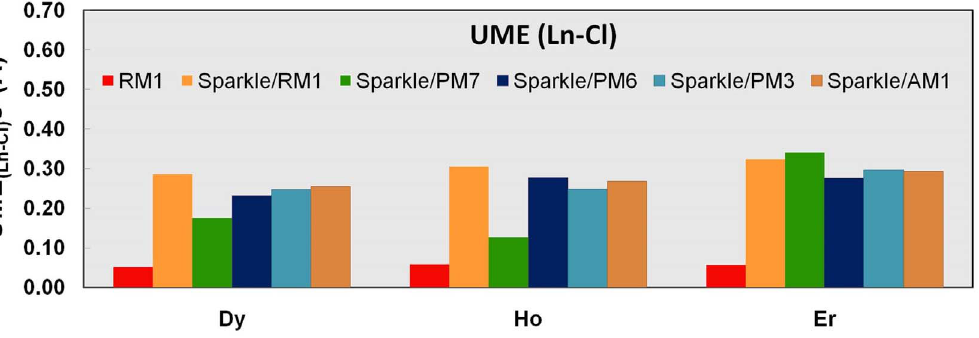
Figure 6. UME (Ln-Cl) s obtained using the RM1 model for the lanthanides and all five versions of the Sparkle Model: Sparkle/RM1, Sparkle/PM7, Sparkle/PM6, Sparkle/PM3 and Sparkle/AM1 for all complexes of the universe set for each of the lanthanide trications: Dy(III), Ho(III) and Er(III). The UMEs are calculated as the absolute value of the difference between the experimental and calculated Ln- Cl interatomic distances, summed up for all complexes, for each of the lanthanides.